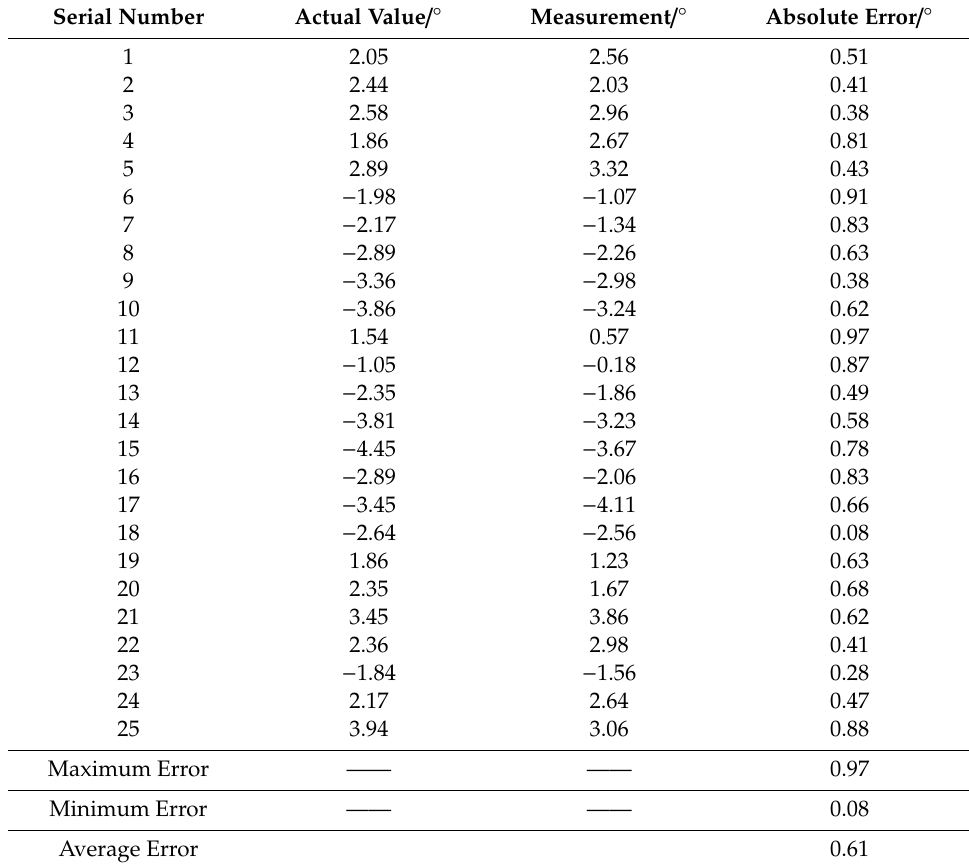
Table 1. The field test